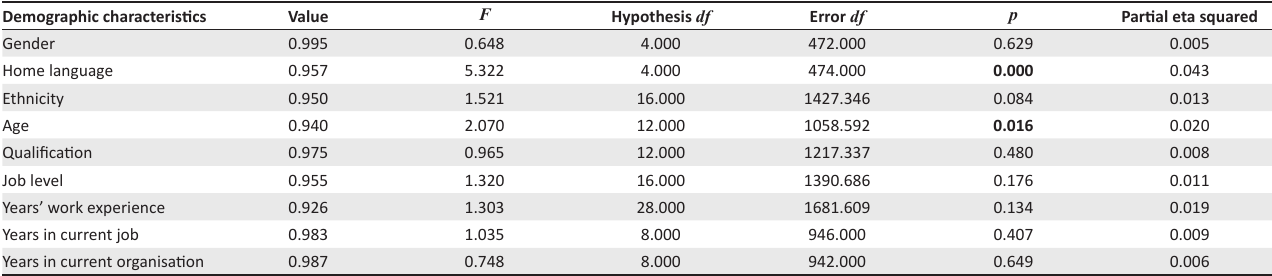
TABLE 6: Multivariate analysis of variance analyses – Business intelligence and demographic groups. Demographic